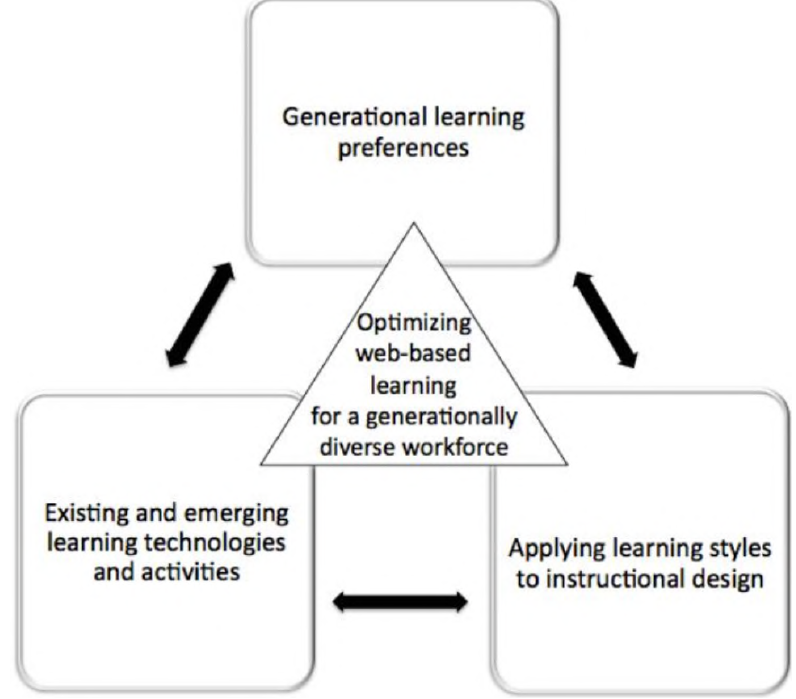
Figure 51: Presentation of paper